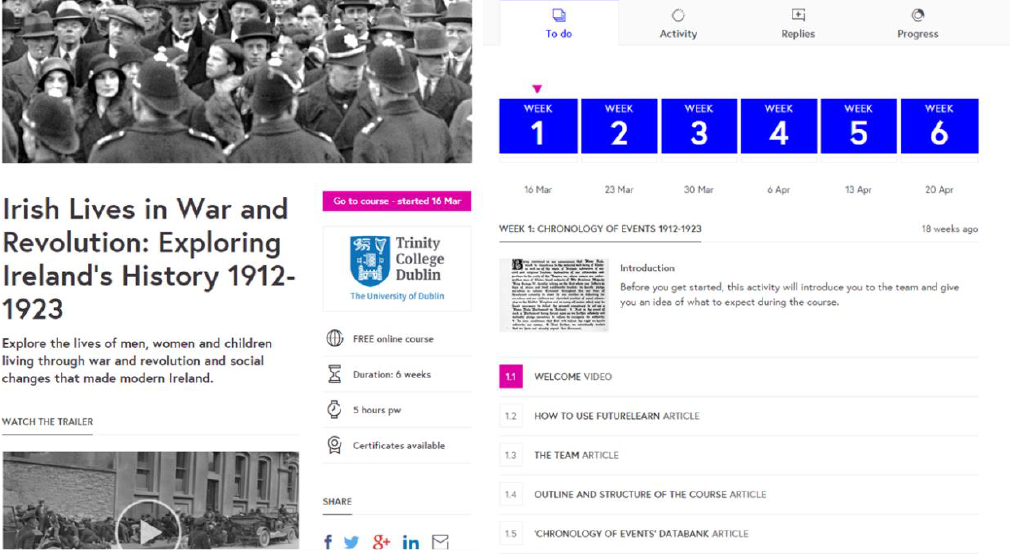
Figure 1. The Irish Lives MOOC home page and week one course